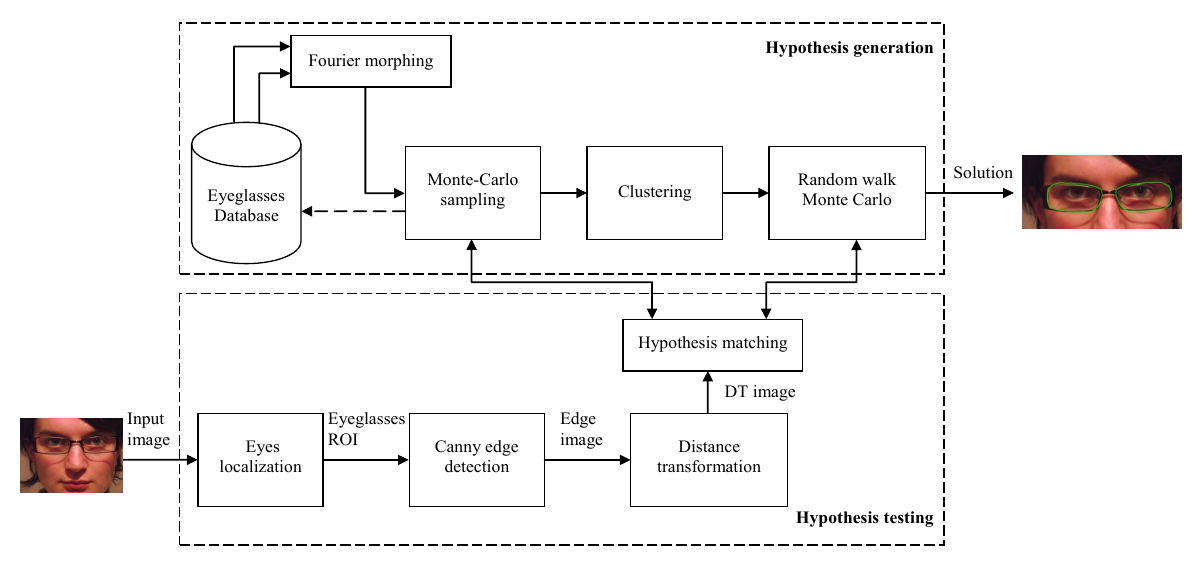
Figure 1. Eyeglasses detection algorithm